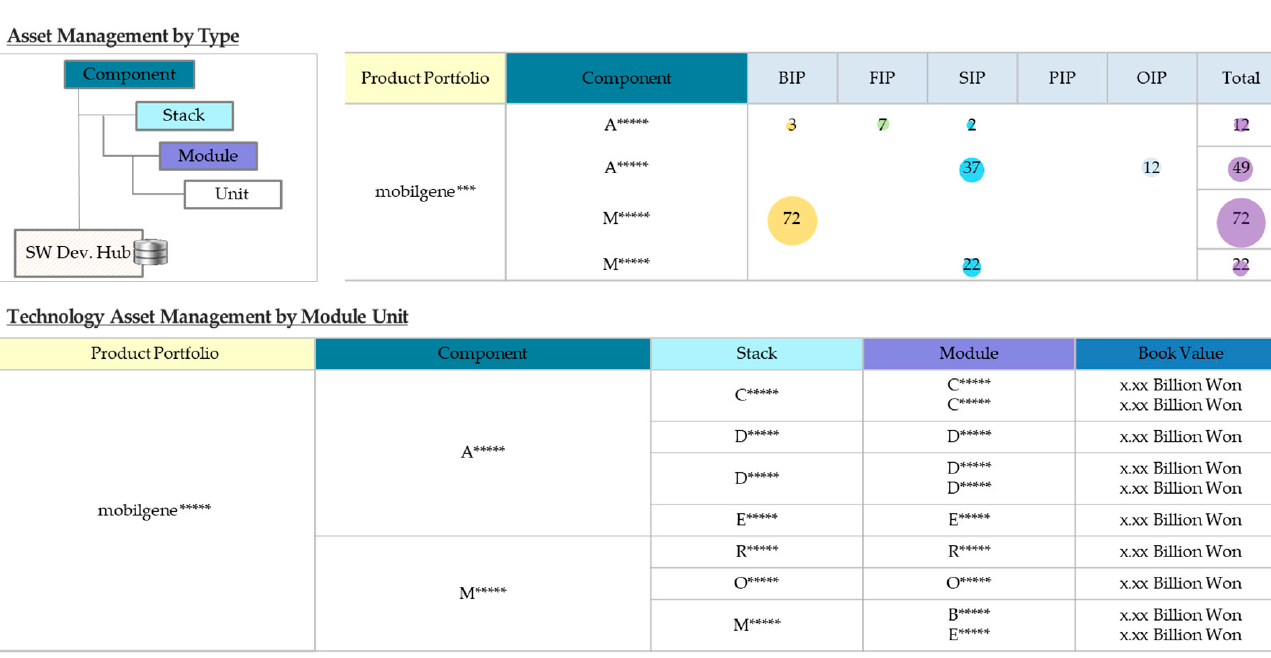
Figure 4. SW Assets Identification.